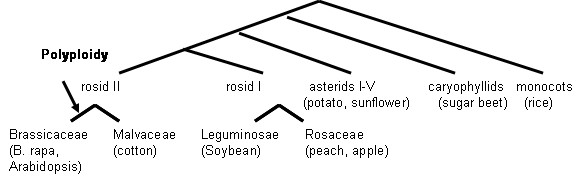
A dendrogram depicting the phylogenetic relationship of peach, Arabidopsis and many other crop species. The probable position of the recent polyploidization event identified from Blanc and corworkers (22) is marked by an arrow. Figure is based on Figure 1 in reference 19 and Figure 5 in reference 22.